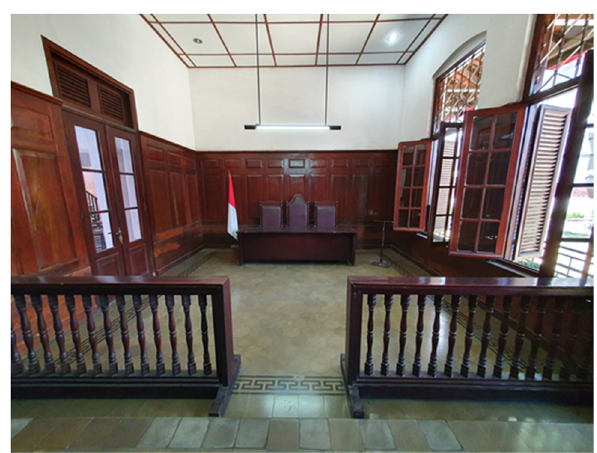
Figure 3: The court chamber in Gedung Indonesia Menggugat